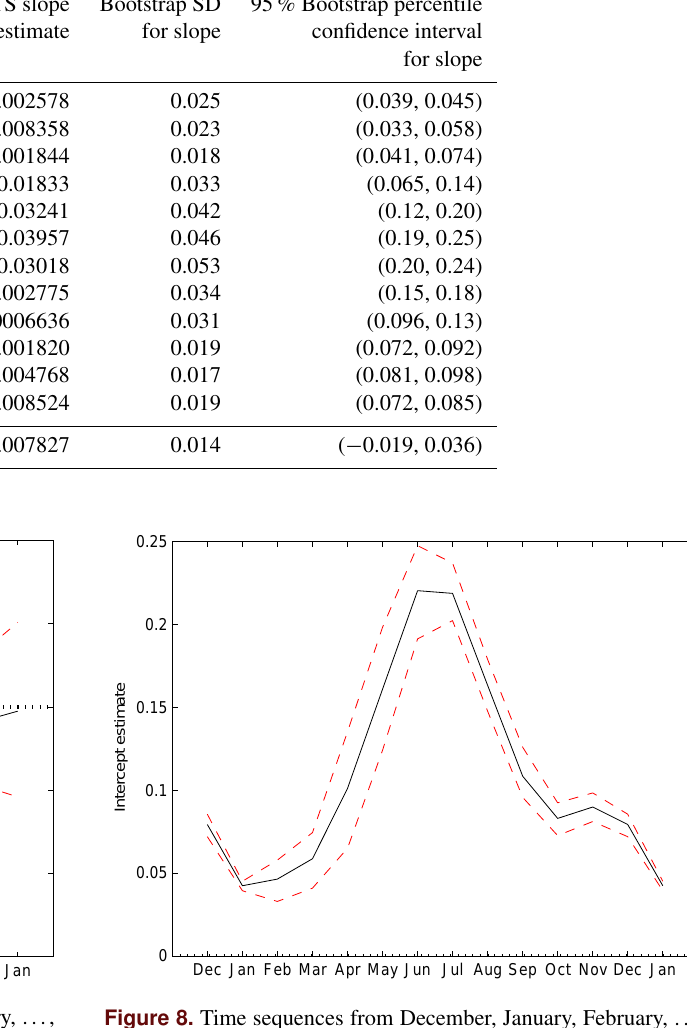
Figure 8. Time sequences from December, January, February, ..., November, December, January, showing WTS estimates of the in- tercept with upper and lower limits from point-wise 95% bootstrap percentile confidence intervals, for the spatial standard deviation vs. spatial mean of the transformed data { v ( s ,t ) } . The intercept esti- mates are a measure of the monthly spatial variability on the trans- formed